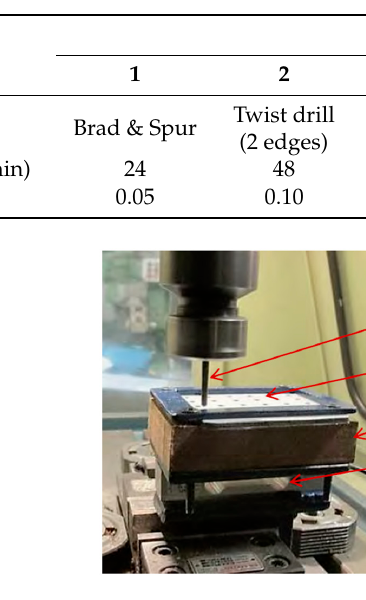
Table 2. Parameters and their levels.